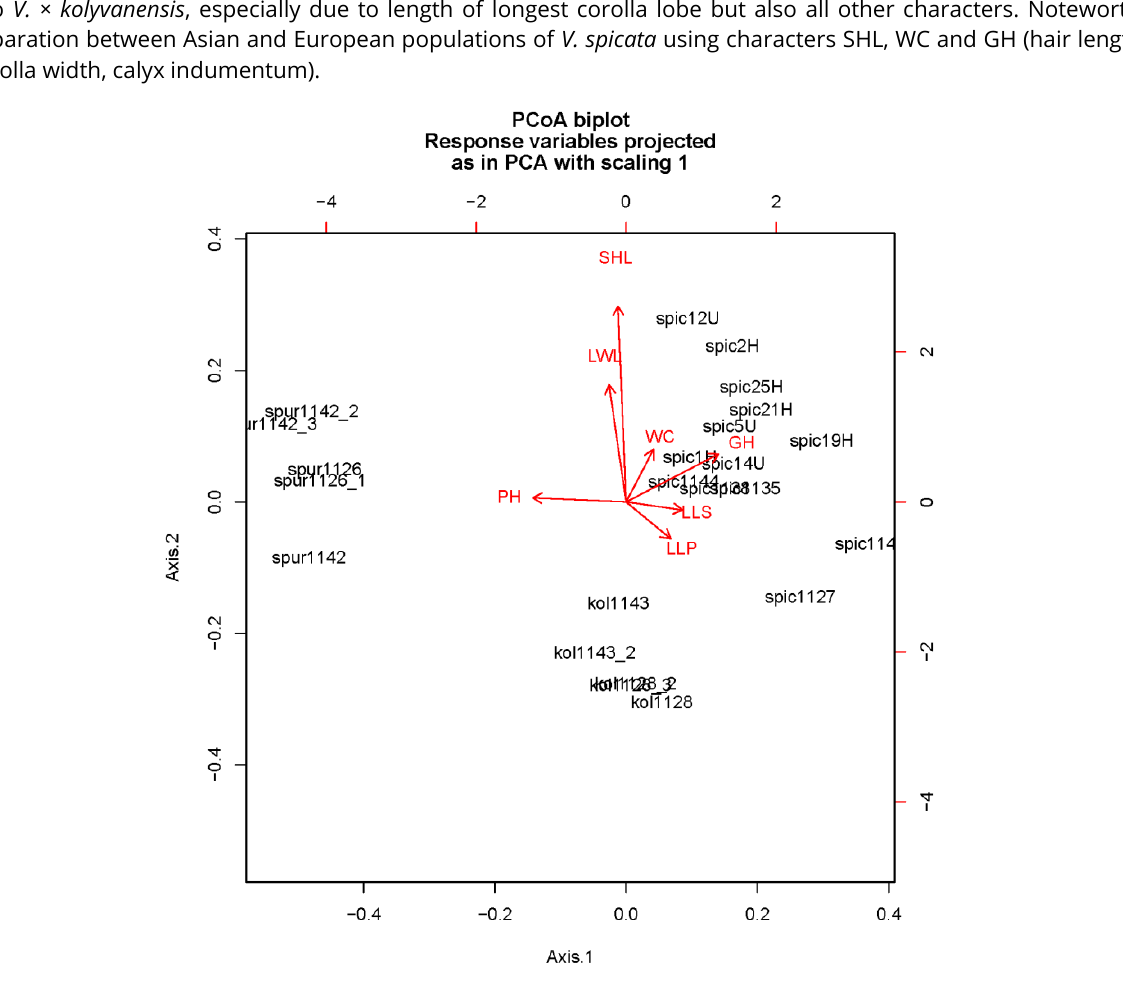
Fig. 2. Principal Co-ordinate Analysis of a matrix of pair-wise Gower distances based on 7 morphological characters scored for 25 individuals from 16 populations of the Veronica × kolyvanensis and its putative parents V. spicata and V. spuria from weastern Altai Mountains and southeastern